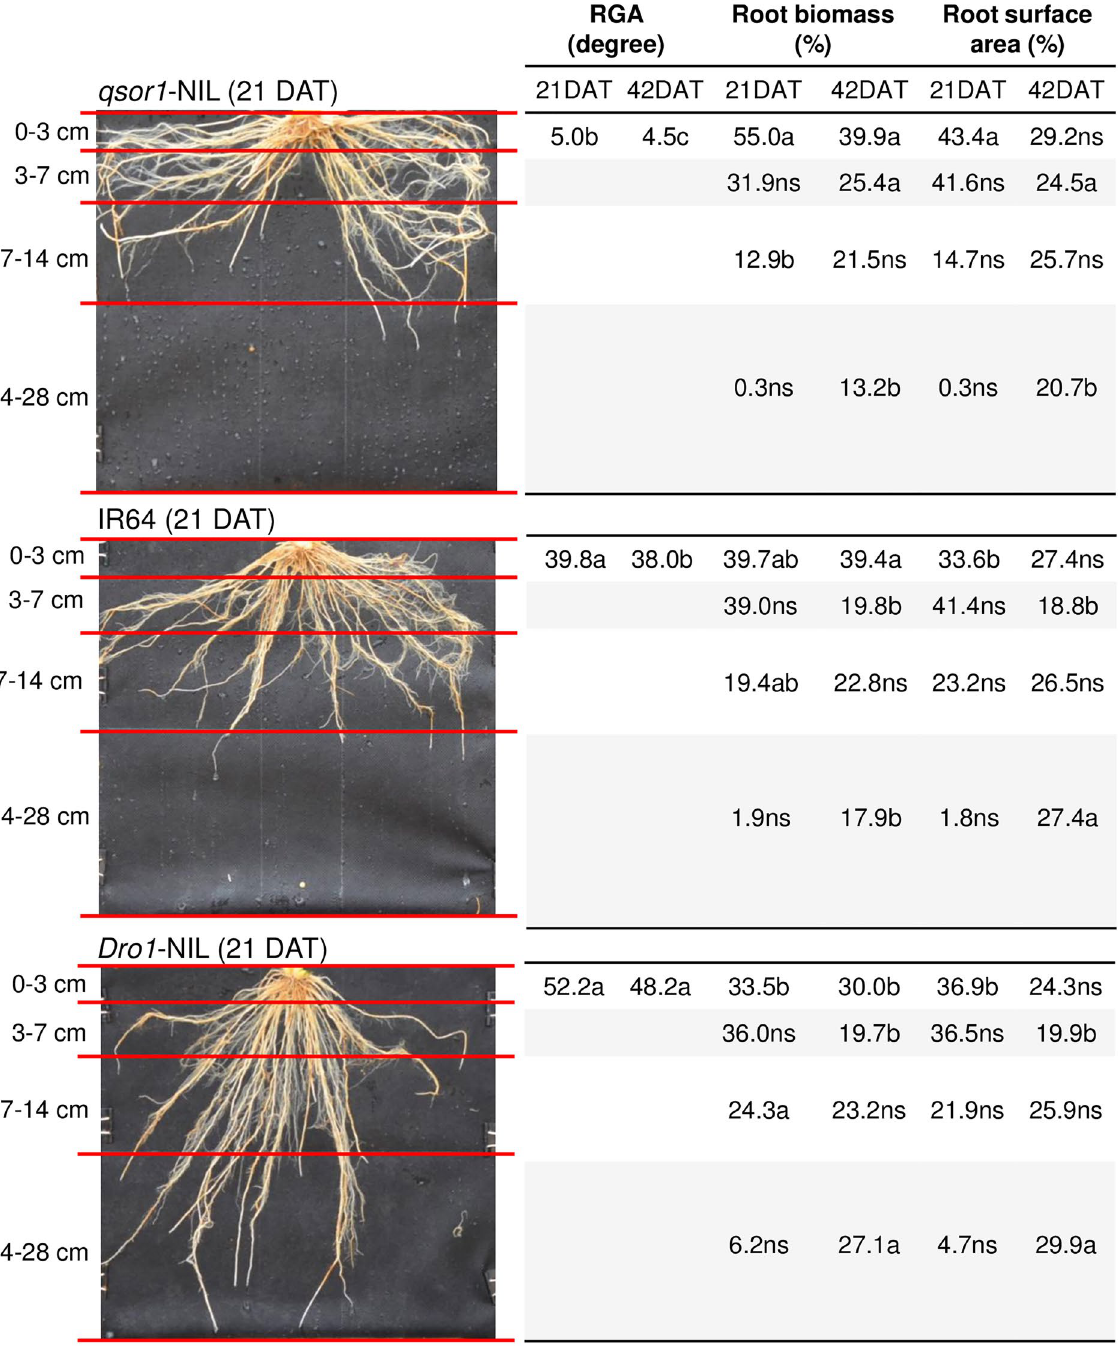
Figure 3. Root growth angle (RGA) and proportions of root biomass and root surface area in different soil layers of qsor1 -NIL, IR64, and Dro1 -NIL at 21 days after transplanting (DAT), and 42 DAT under the P incorporation (P inco ) treatment. Different letters in the same soil layer indicate significant differences among genotypes at 5% of Tukey’s HSD test. ns not significant at 5%